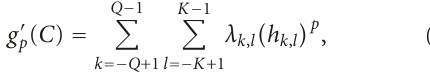
possible to place a higher importance on the minimization of sidelobe peaks in a subregion of the delay-Doppler space,